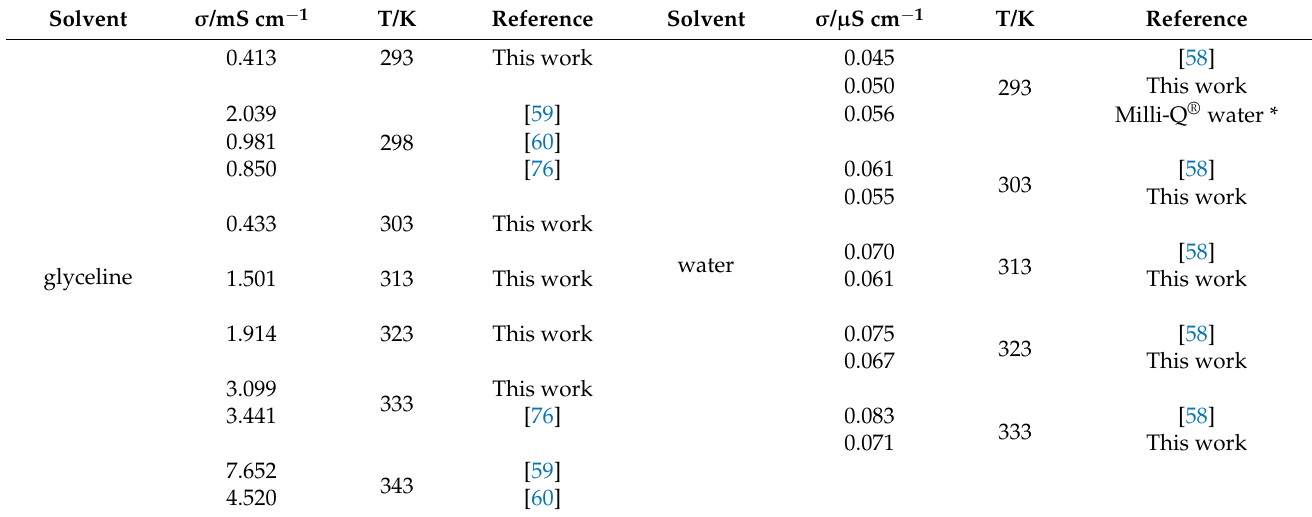
Table 8. Ionic conductivity values for glyceline and water at different temperatures (published and obtained